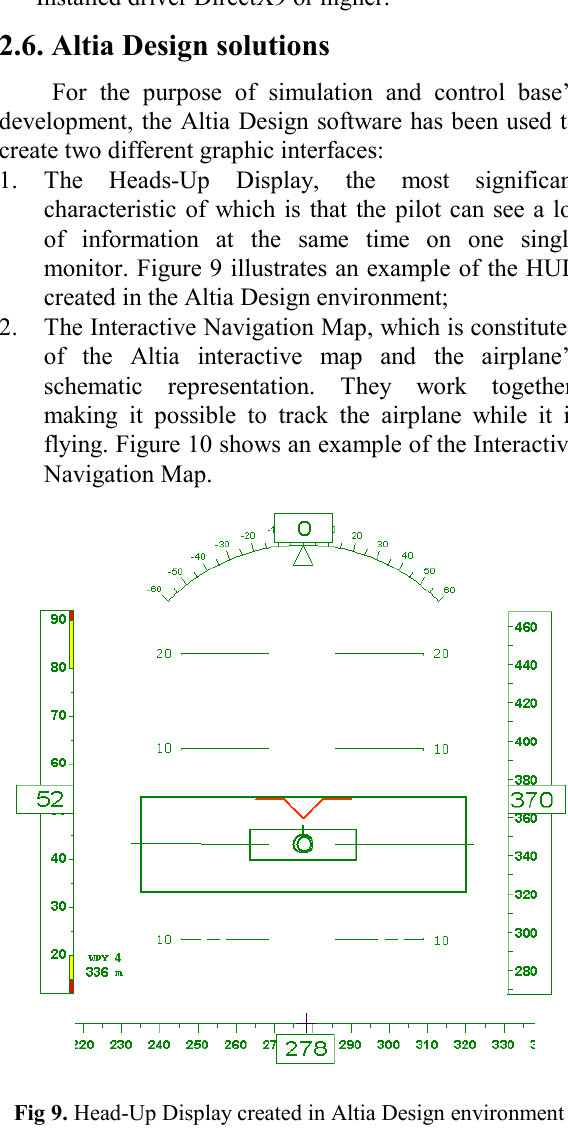
Fig 9. Head-Up Display created in Altia Design environment